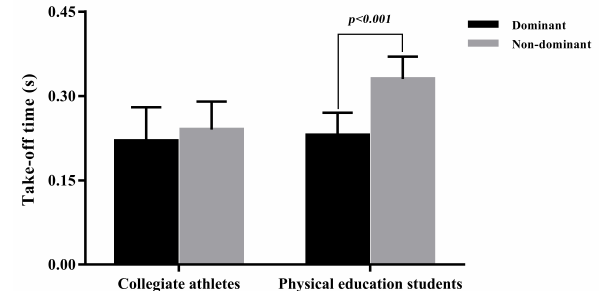
Fig. 3. Comparison of lower limb take-off time of dominant and non-dominant leg at H-SLDJ.